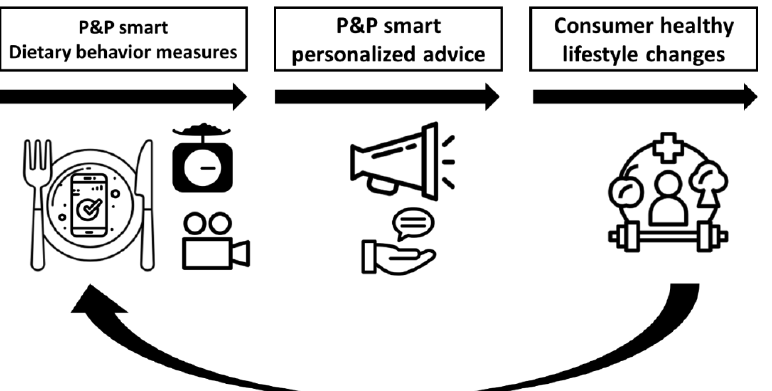
Figure 1. Overview of P&P efforts on technology driven dietary behavior assessment, and personalized interventions and coaching.